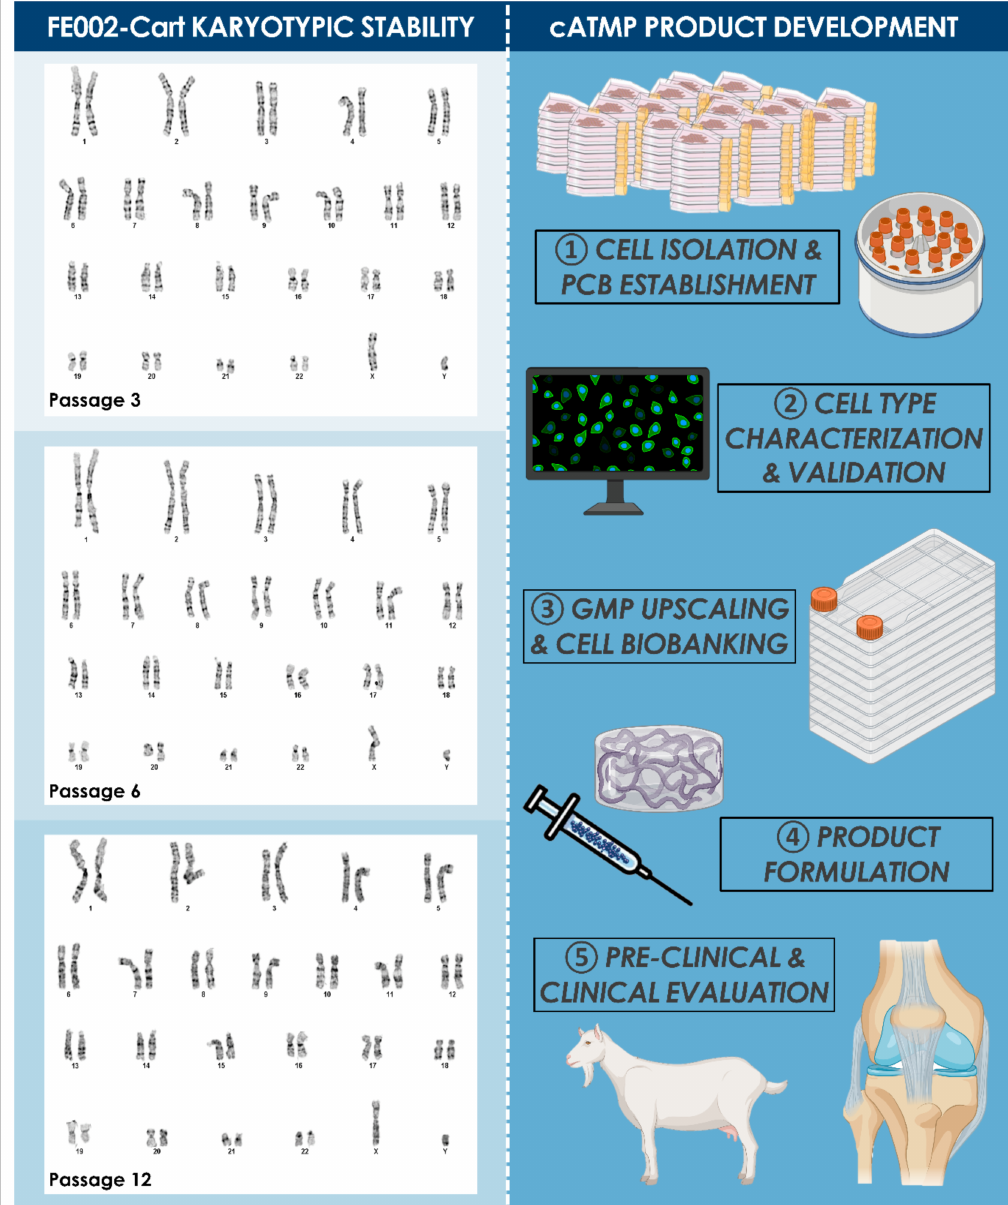
Figure 3. Karyotypic stability of the FE002-Cart cell type (i.e., Passages 3, 6, and 12) and essential steps in view of cATMP development with standardized FPC biobanks under the Swiss Fetal Transplantation Program. A normal 46,XY